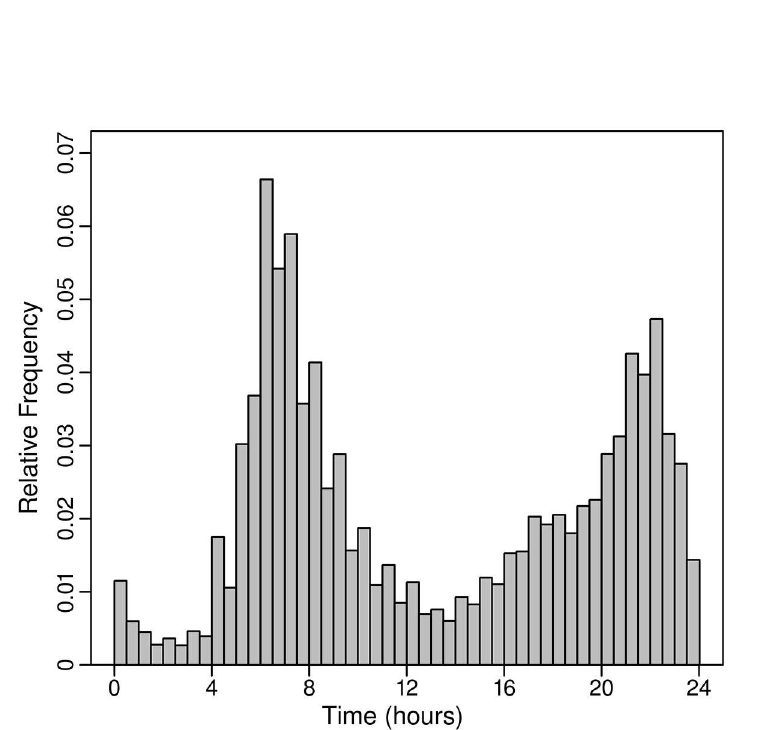
Fig 4. Weighted histogram of starting times for cases with two ATUS grooming events. N =